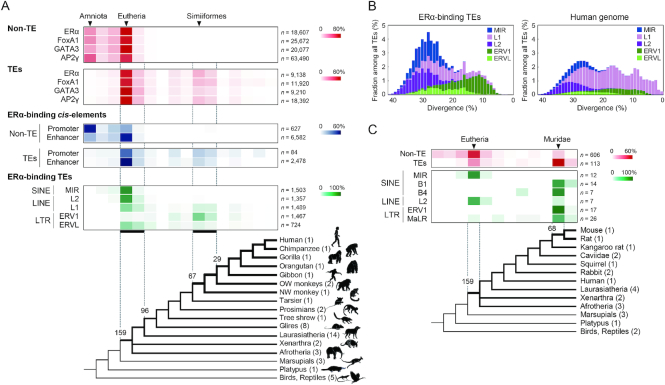
Estimated time of acquisition of the transcription factor binding sequences during mammalian evolution. (A) Heat maps represent the proportion of the number of binding sites for each transcription factor as compared among the clades wherein the orthologs are distributed. The ERα-binding sites were mapped separately among the promoters and enhancers (blue), as estimated by ChromHMM (Supplementary Figure S2), or among the top five highest contributing TE categories, MIR, L2, L1, ERV1 and ERVL (green) (see also Supplementary Figure S8). Values above the tree represent divergence times (in million years ago, Mya). The number of species analyzed is shown after the clade names. OW monkeys, Old World monkeys; NW monkey, New World monkey. (B) Distribution of the top five contributing TE groups according to the divergence (%) from the consensus sequence compared among ERα-binding TEs (left) and all TE copies (right) in the human genome. Note that the x axis is inverted to show old and young copies on the left and right, respectively. (C) Proportion of the number of ERα-binding sites in the mouse mammary gland as compared among the clades wherein the orthologs are distributed. The TE-associated binding sites (red) were separately mapped among the top six highest contributing TE categories, MIR, B1, B4, L2, ERV1 and MaLR (green).